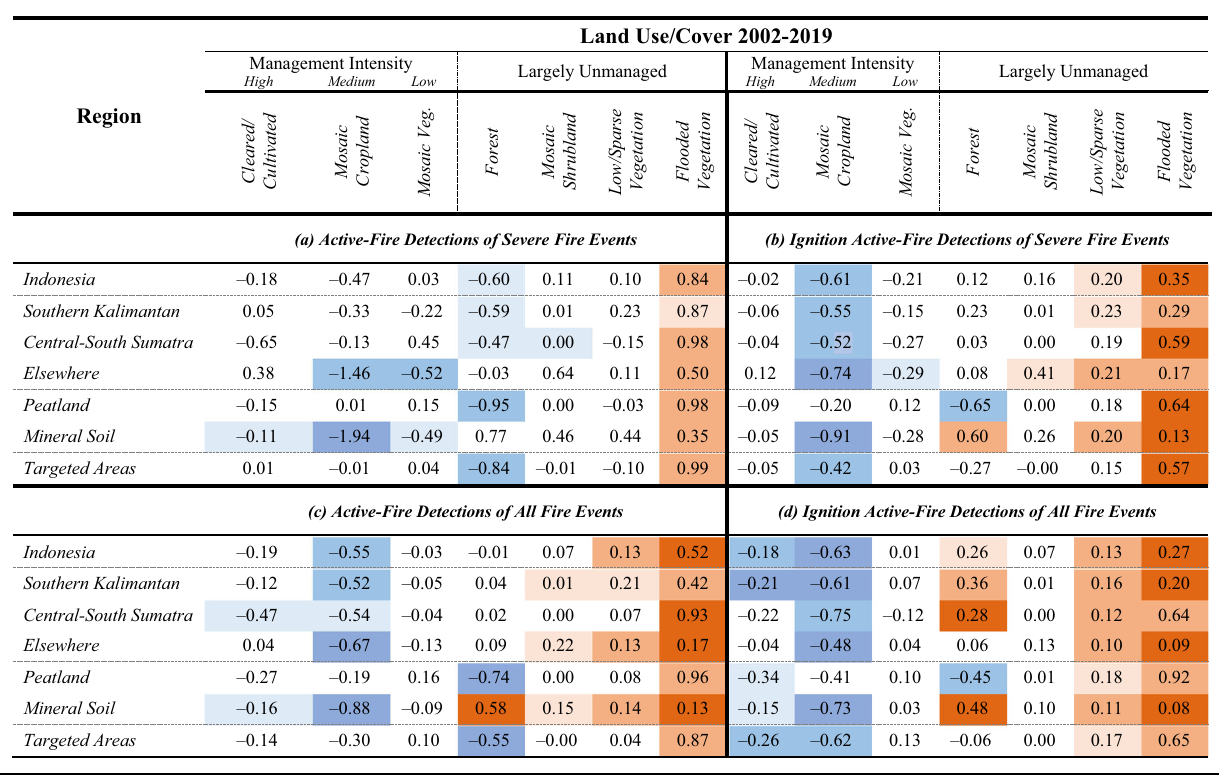
Table 2 Estimated percentage annual change in land uses/cover frequency across fi re events or ignitions, based on annual observations of land use/cover and fi re activity over 2002 – 2019, by region, for either active- fi re detections of severe fi re events, ignition active- fi re detections of severe fi re events, active- fi re detections of all fi re events, and ignition active- fi re detections of all fi re events.